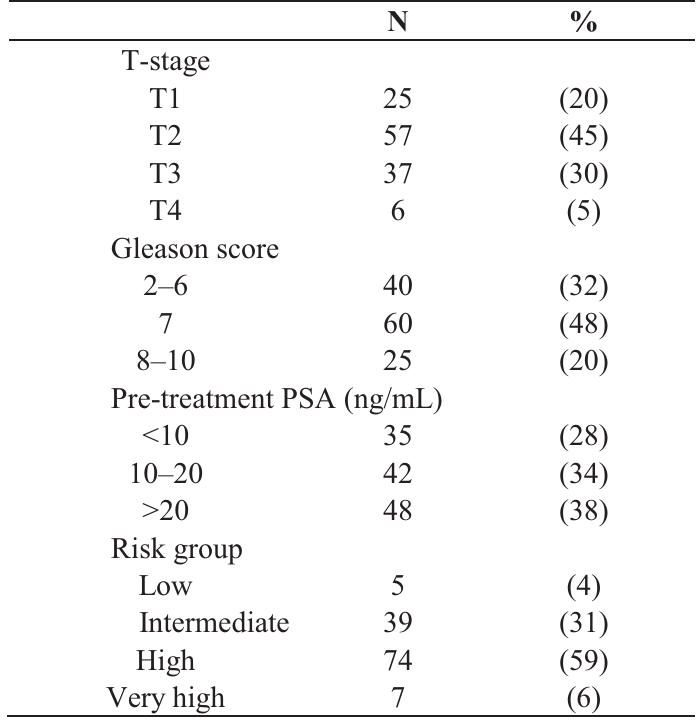
Table 1. Patient